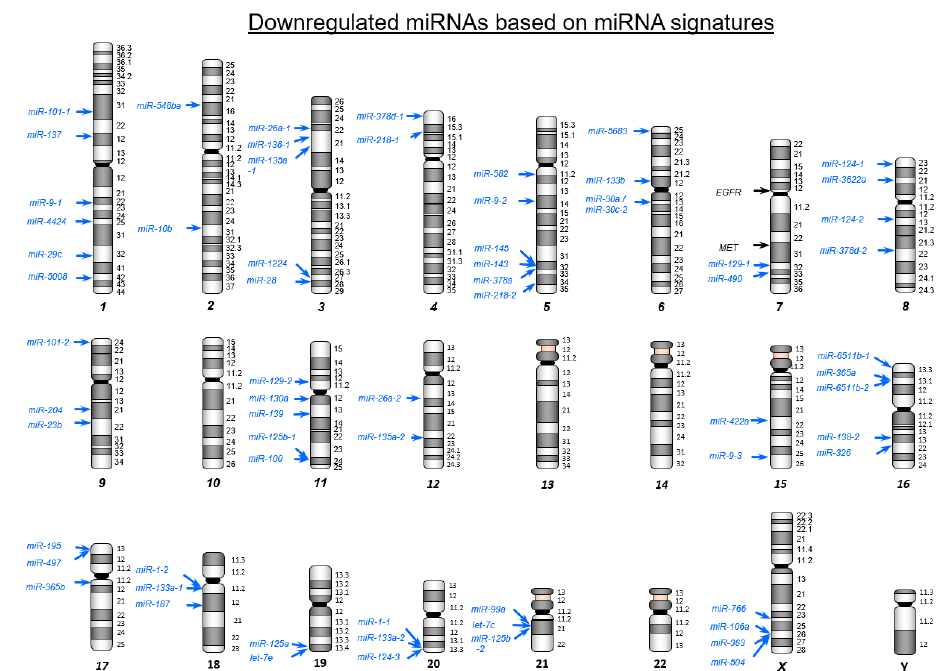
Figure 2. Chromosome mapping of aberrantly downregulated miRNAs in colorectal cancer (CRC). Downregulated miRNAs in CRC tissues are mapped on human chromosomes. A total of 70 miRNAs are identified by our RNA sequence based signature. In order to ensure the validity of our signature created in this study, we compared to previous miRNA signatures of CRC [23–25]. Two miRNAs, miR-592 (upregulated miRNA) and miR-139-5p (downregulated miRNA) were common miRNAs to all four independent signatures (Table S4). Eight miRNAs, miR-335-3p , miR-552-5p , miR-3180-5p , miR-301b and miR-3144-3p (upregulated miRNA), and miR-378a-5p , miR-490-3p, and miR-422a